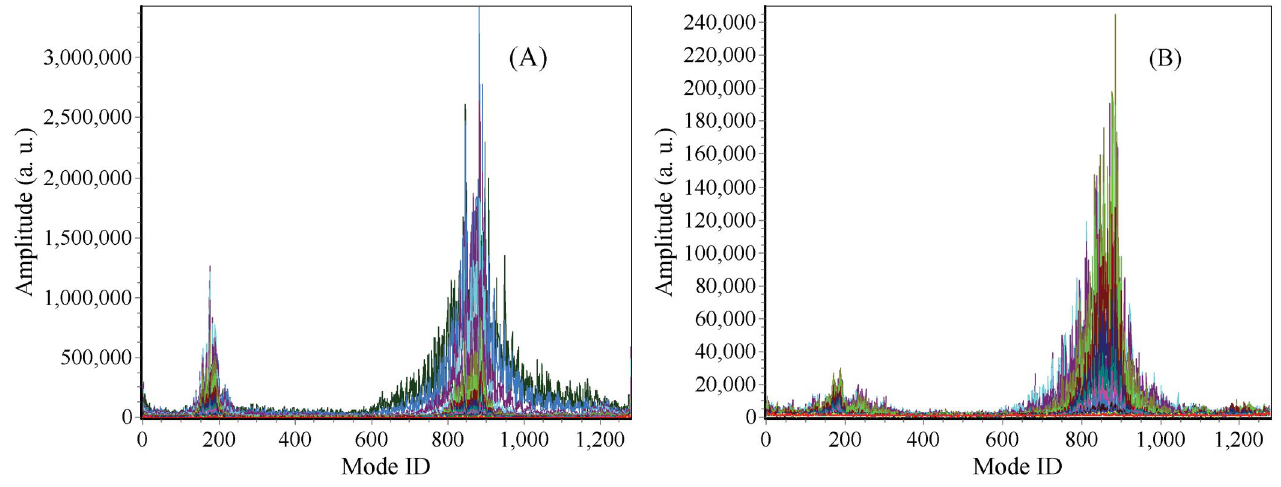
(cid:1) 0% , L (cid:1) 0% ]. sol sol